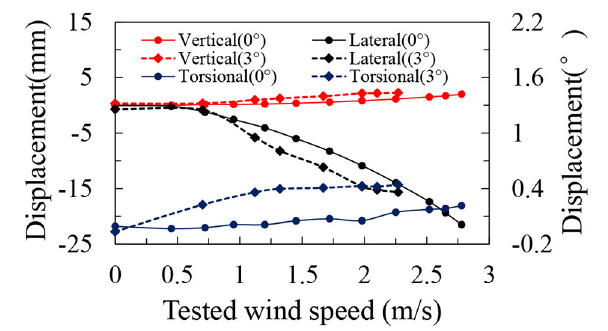
FIGURE 22 | Mean responses under uniform flow at mid-span.